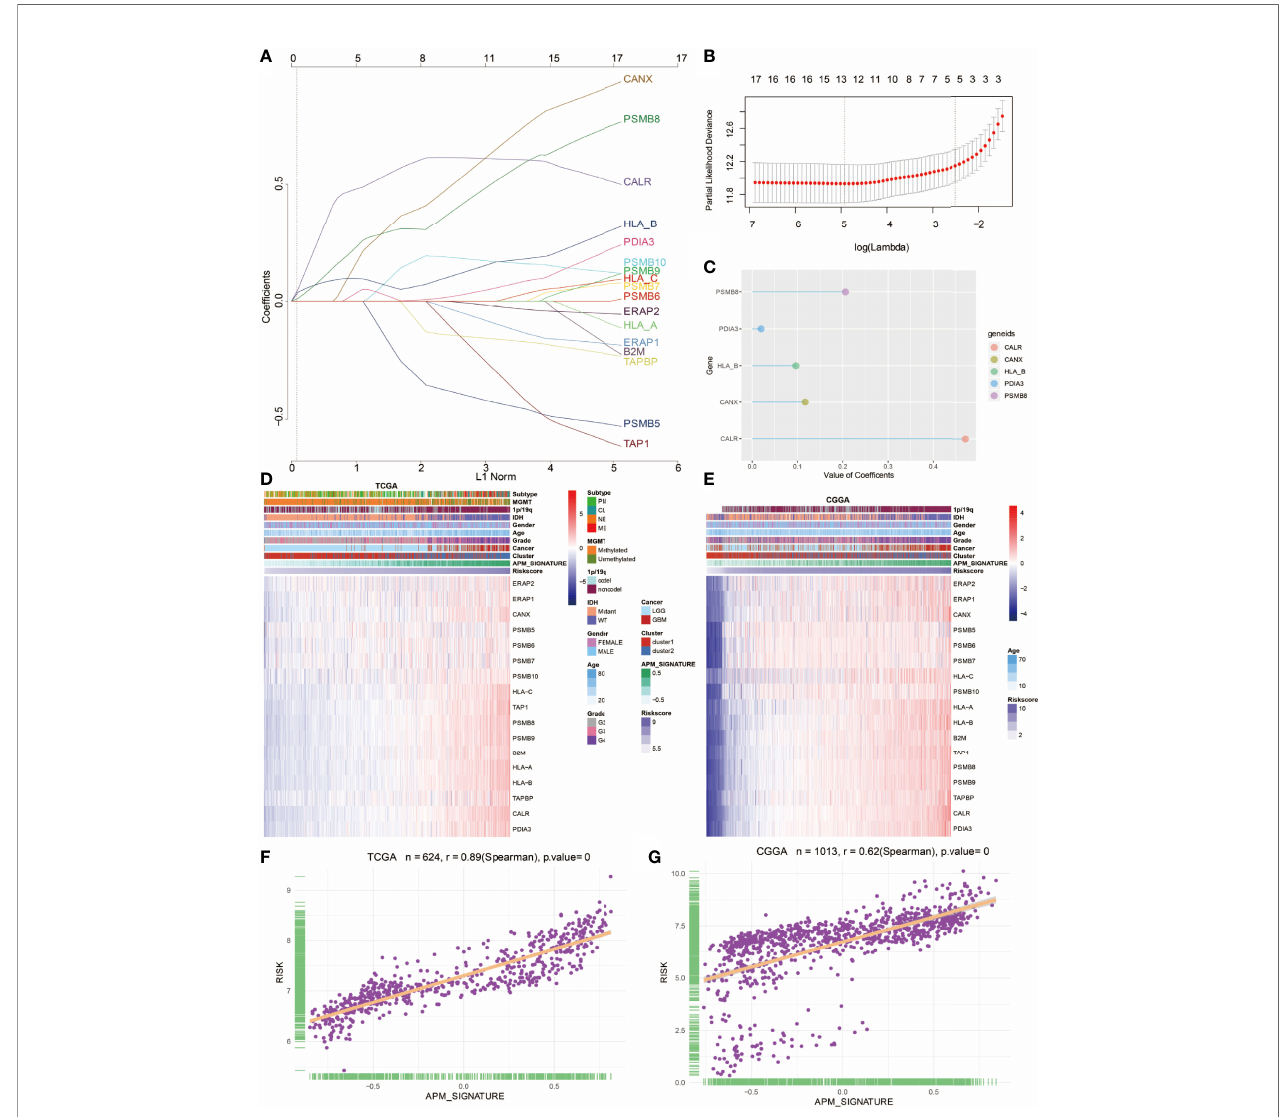
FIGURE 4 | Construction of APM signature gene-based risk score. (A) LASSO regression analysis showing the coef fi cients of APM signature genes. (B) Partial likelihood deviance of APM signature genes. (C) Bubble plot depicting the APM-derived risk signature genes. (D) Heatmap depicting the association between APM signature genes and risk score in the TCGA. (E) Heatmap depicting the association between APM signature genes and risk score in the CGGA. (F) The correlation between APM signature and risk score in TCGA. (G) The correlation between APM signature and risk score in the